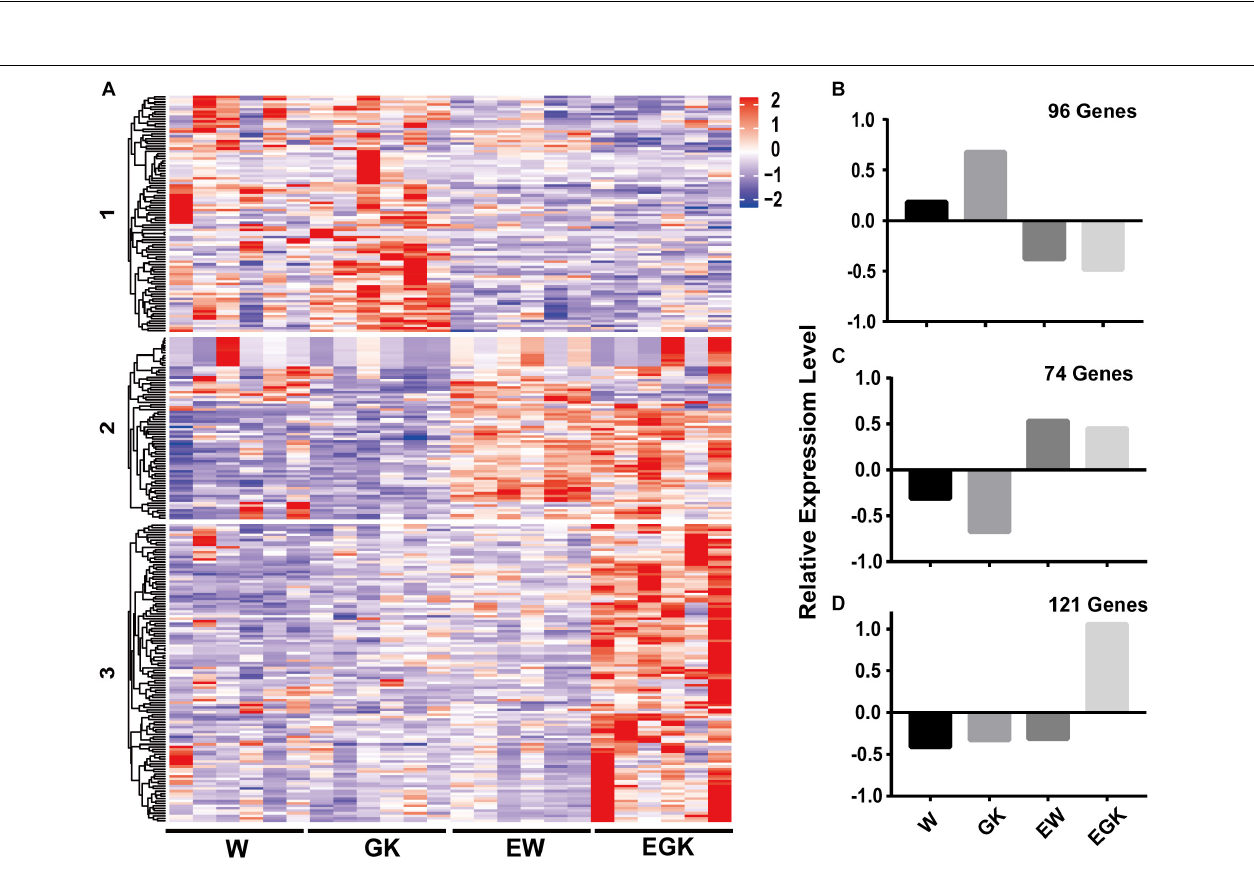
FIGURE 4 | GO and KEGG enrichment analysis of DEGs in exercise GK vs. GK comparison. The top 20 significantly enriched GO terms (A) and KEGG pathways (B) .